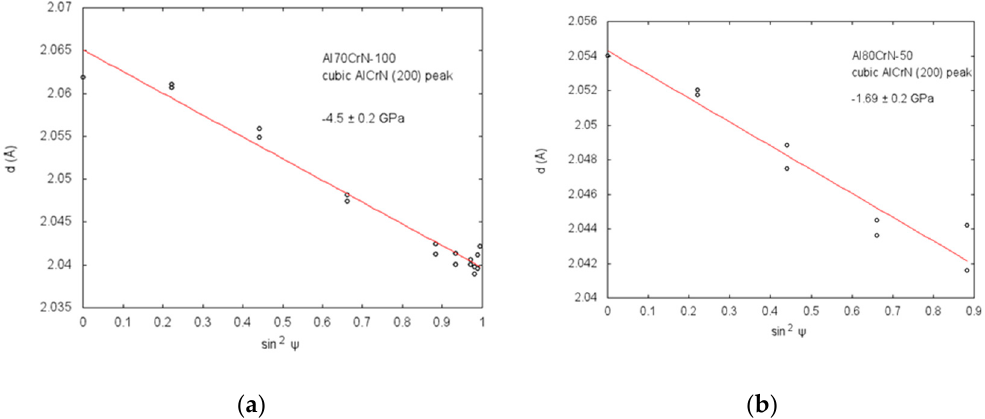
Figure 4. Representative d(sin 2 Ψ ) plots for the (200) peak of cubic CrAlN in Al70CrN–100 ( a ) and Al80CrN–050 ( b ).